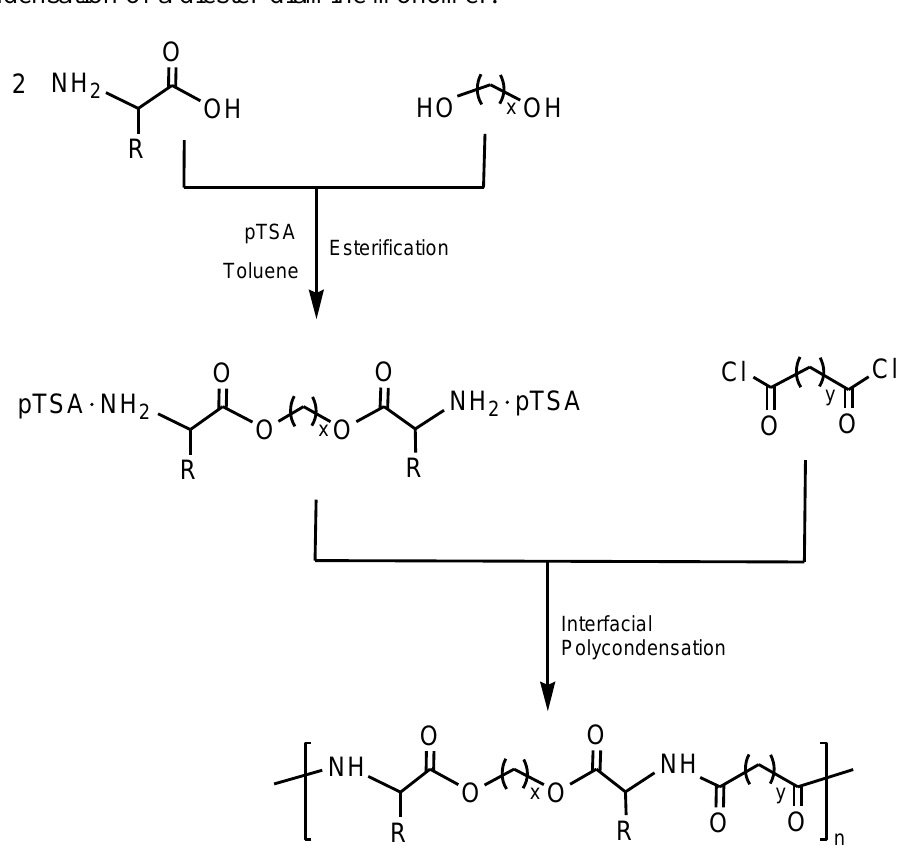
Figure 4. Poly(ester amide)s incorporating  -amino acids prepared by interfacial polycondensation of a diester-diamine monomer.